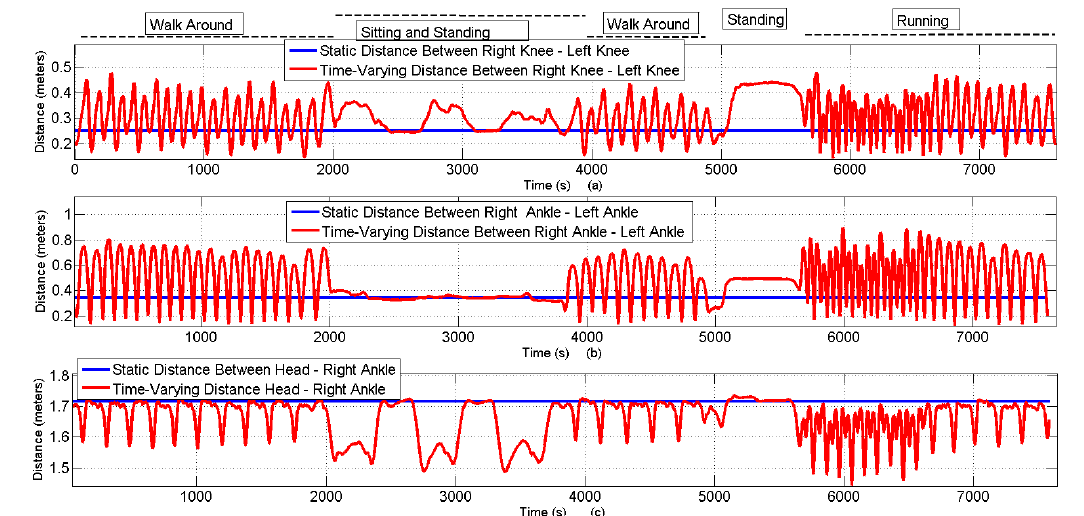
Figure 11. Comparison of static and time-varying distances under different scenarios over time. ( a ) Time varying distances between the right knee and left knee; ( b ) Time varying distances between the right ankle and left ankle; ( c ) Time varying distances between the head and right